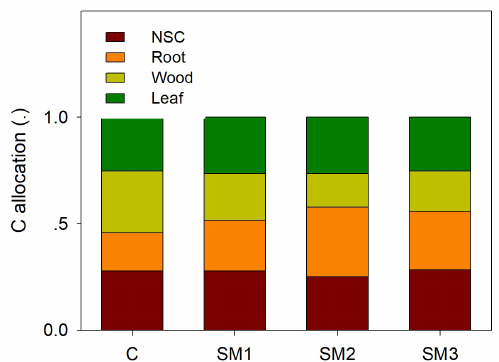
Figure 9. Coefficients for the partitioning of NPP to nonstructural C (NSC), root, woody, and leaf in the C-only model (C) and the C–N coupling model with three schemes (SM1, SM2, and